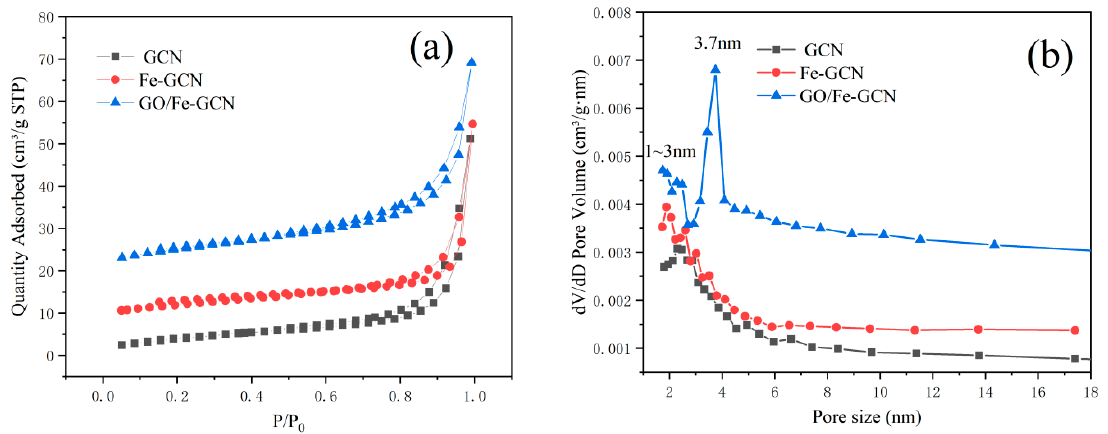
Figure 5. N 2 adsorption-desorption isotherms ( a ) and BJH pore size distributions ( b ) for GCN, Fe-GCN, and